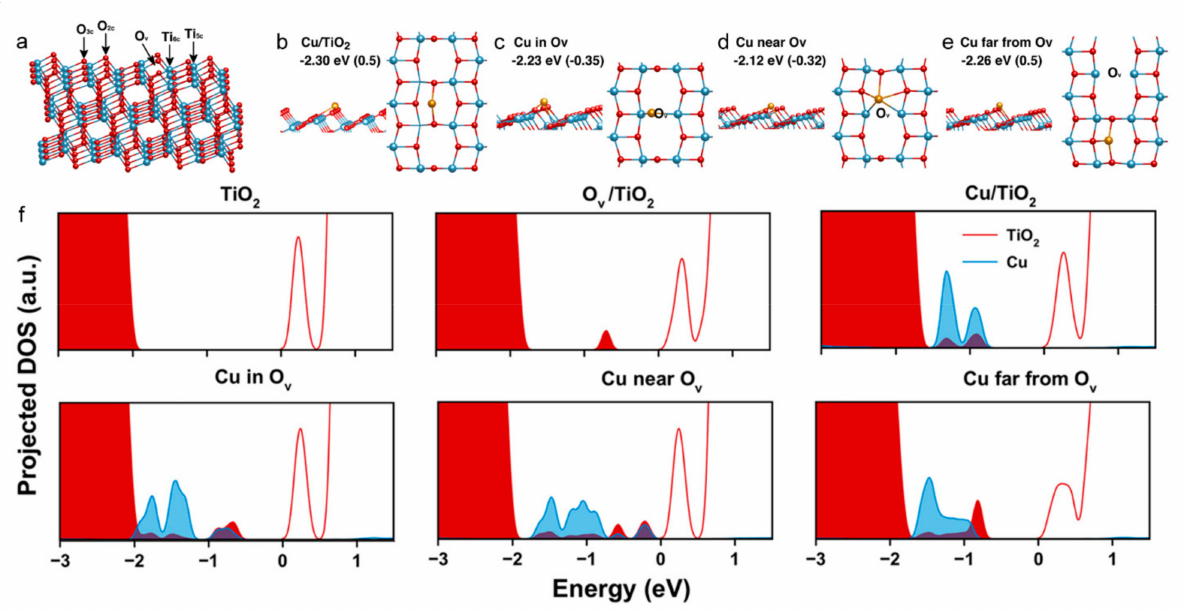
Figure 8. ( a ) Supercell—a (2 × 4) representation of the anatase (101) surface. Indicated are different atom types and an oxygen vacancy (O v ). The subscripts indicate the coordination number of the atoms, e.g., O 2c is a two-coordinated oxygen atom. O V indicates an oxygen vacancy. ( b – e ) Cu adsorption over TiO 2 anatase (101) surfaces. Cu adsorption ( b ) over a stoichiometric surface, ( c ) in an oxygen vacancy, ( d ) near an oxygen vacancy, and ( e ) far from the oxygen vacancy. The Cu atom is depicted in orange. Given are adsorption energies while numbers in parentheses are calculated Cu charges. ( f ) Projected density of states plots for adsorbed Cu. The zero-energy level is set at the conduction band edge. The filled curves represent occupied states, while unfilled curves represent unoccupied states. Adopted with permission from Ref.